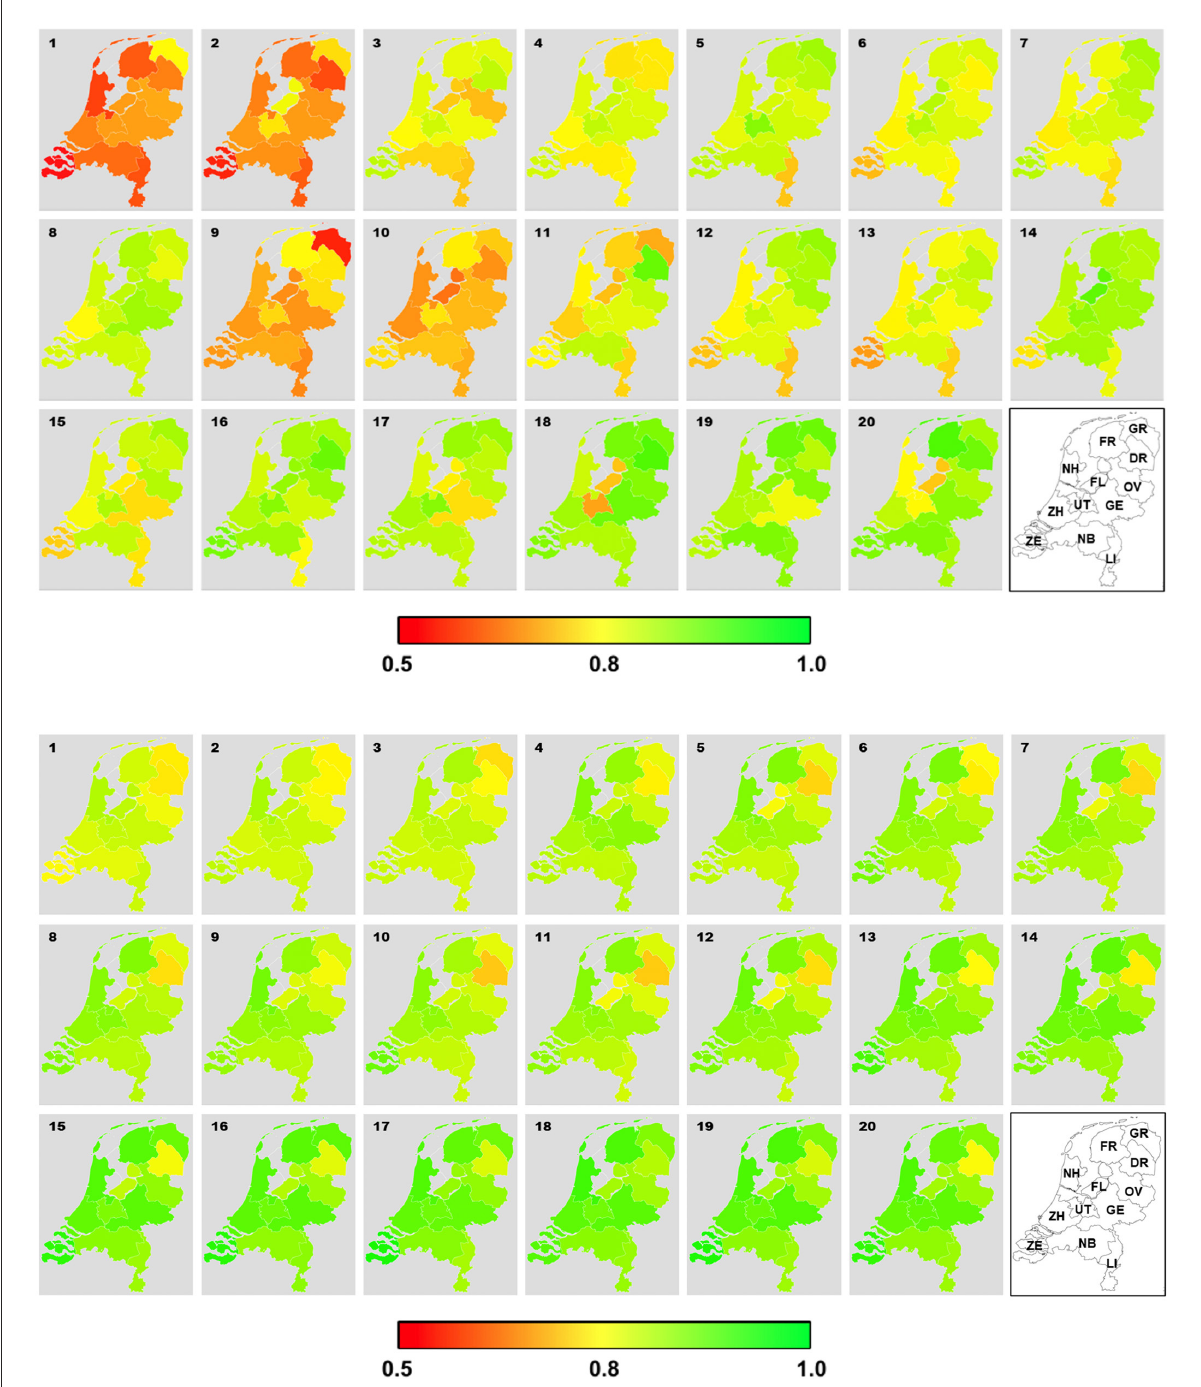
FIGURE6 Geographical variation of stance on social distancing over the 20 weeks estimated from Twitter data (top) and survey data (bottom). ZH, Zuid-Holland; NH, Noord-Holland; UT, Utrecht; NB, Noord-Brabant; LI, Limburg; GE, Gelderland; FL, Flevoland; OV, Overijssel; GR, Groningen; ZE, Zeeland, FR, Friesland; DR, Drenthe. Redder and greener colors represent stance between 0.5 and 1.